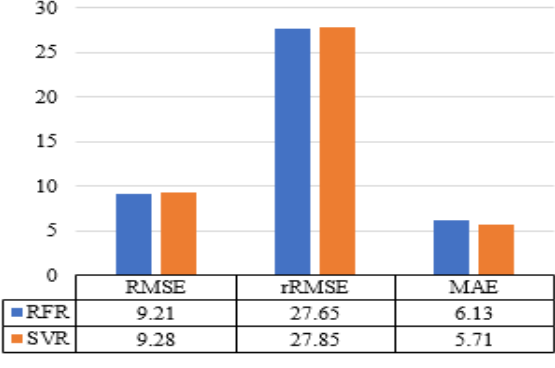
Figure 3. Ranking Landsat 8 indices in building model based on RF algorithm.